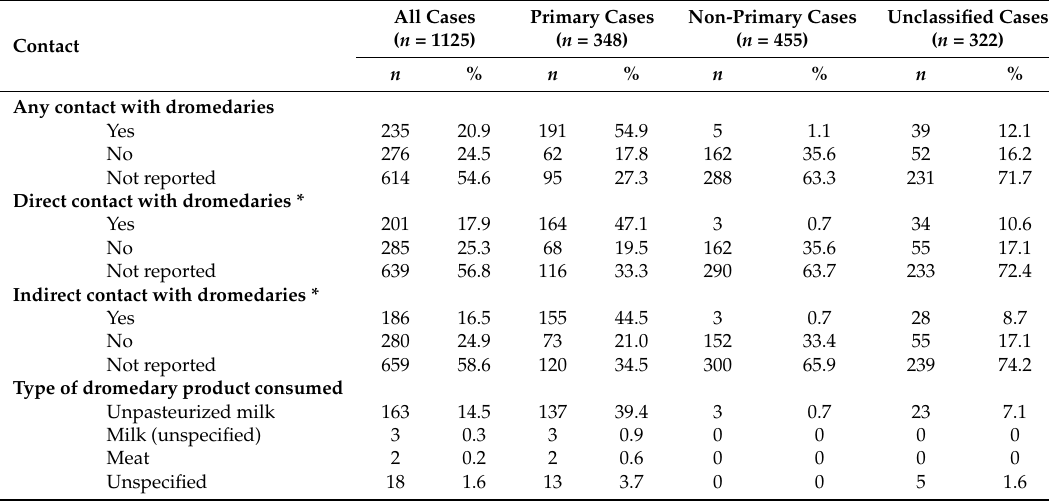
Table 2. Direct and indirect contact with dromedaries among laboratory-confirmed MERS-CoV cases reported to WHO between 1 January 2015 and 13 April 2018, n = 1125. Results are presented as frequencies (%), unless otherwise stated.